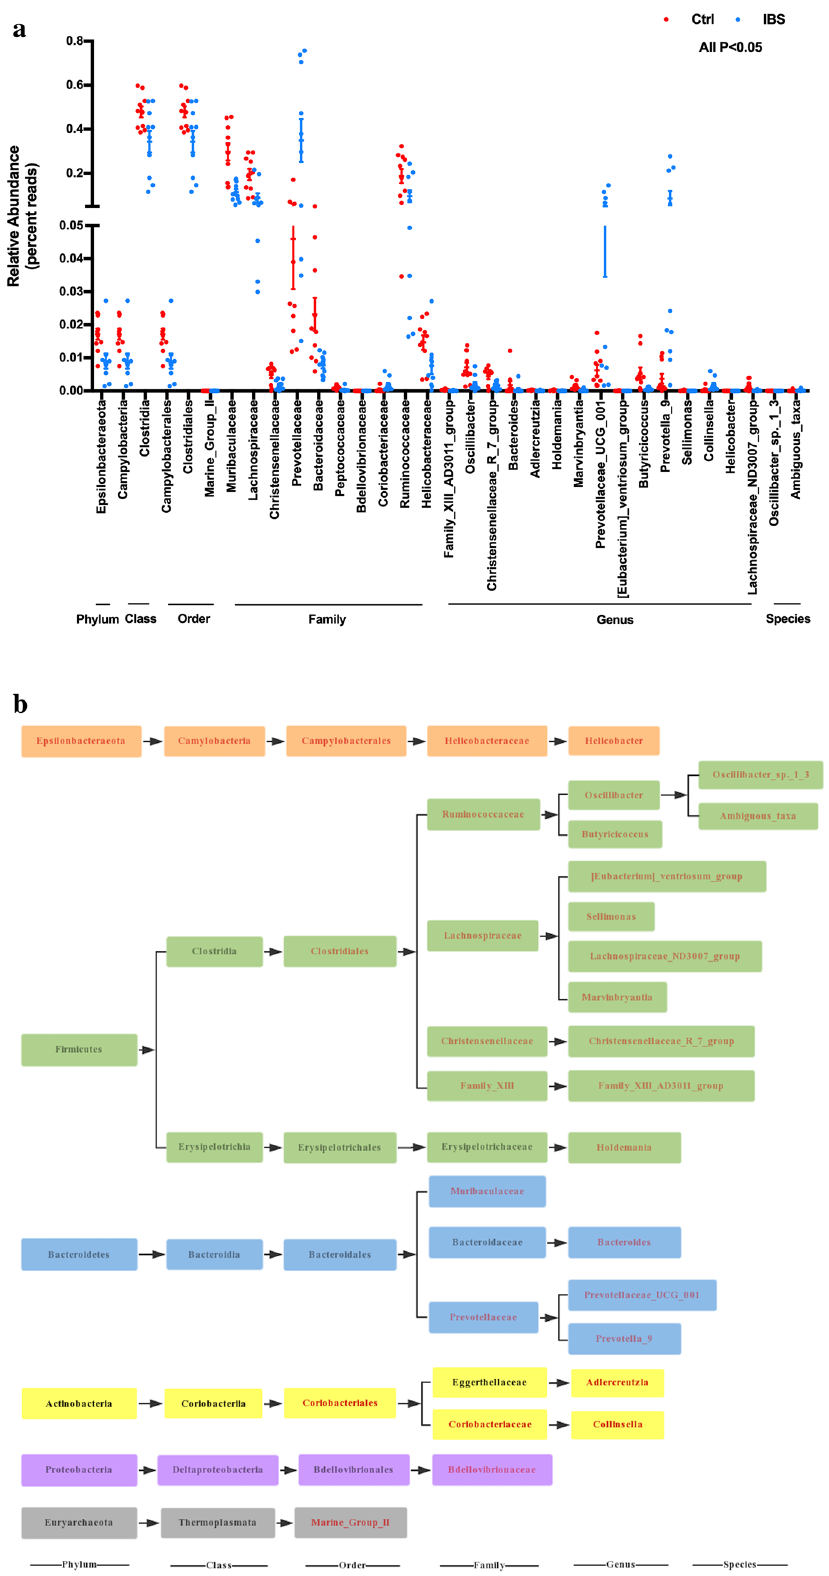
Figure 3. ( a ) The relative abundances in bacterial phylum, class, order, family, genus and species levels in the control (n = 10) and IBS (n = 10) groups, P < 0.05. ( b ) The dendrogram of the different gut microbiome obtained from the control (n = 10) and IBS (n = 10) groups, the statistical difference is presented in red ( P < 0.05). Statistical significance was determined by one-way analysis of variance (ANOVA) with Fisher’s least significant difference (LSD) post hoc